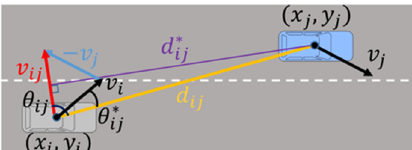
Figure 5 Arbitrary two-vehicle scenario